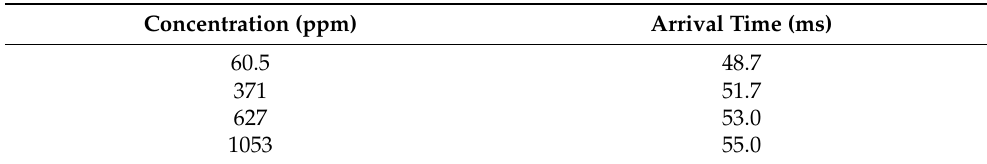
Figure 5. Relationship between concentration and arrival-time shift for MEK. The measurement er- ror of the flow rate was estimated to be ~3%.